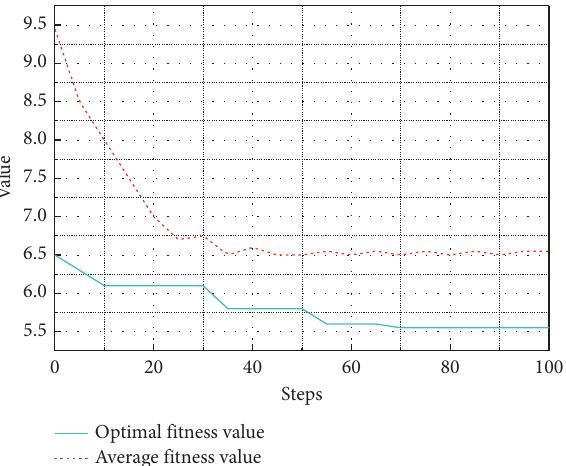
Figure 4: Model convergence curve.